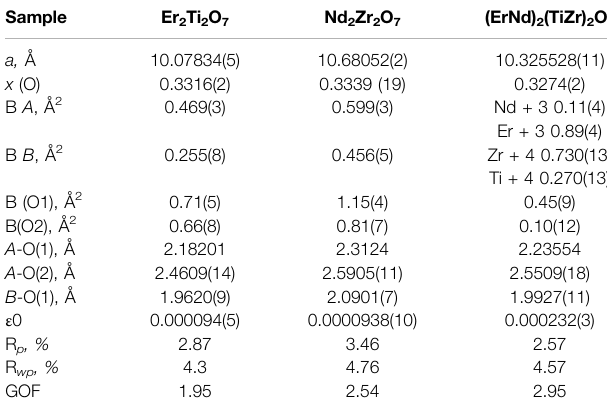
TABLE 1 | Re fi ned parameters for samples Er 2 Ti 2 O 7 , Nd 2 Zr 2 O 7 and (ErNd) 2 (TiZr) 2 O 7 fromS-XRDdata.Where a isthelatticeparameter, x (O)isthe value of the 48f site, B A is the overall isotropic displacement parameter of the A cation , B B istheoverallisotropicdisplacementparameterofthe B cation , B(O1)is the overall isotropic displacement parameter ofthe oxygen at the O1